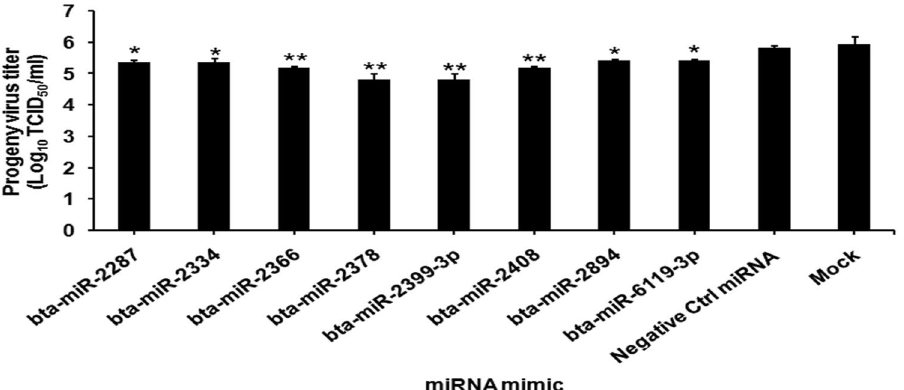
Figure 2. The FMDV progeny yield (TCID 50 /ml) at 12 h post infection in BHK-21 cells transfected with 8 selected miRNAs in comparison with a negative control miRNA and mock control. The results are expressed as the "mean ± standard deviation" from three independent experiments, * p < 0.05, ** p < 0.01.